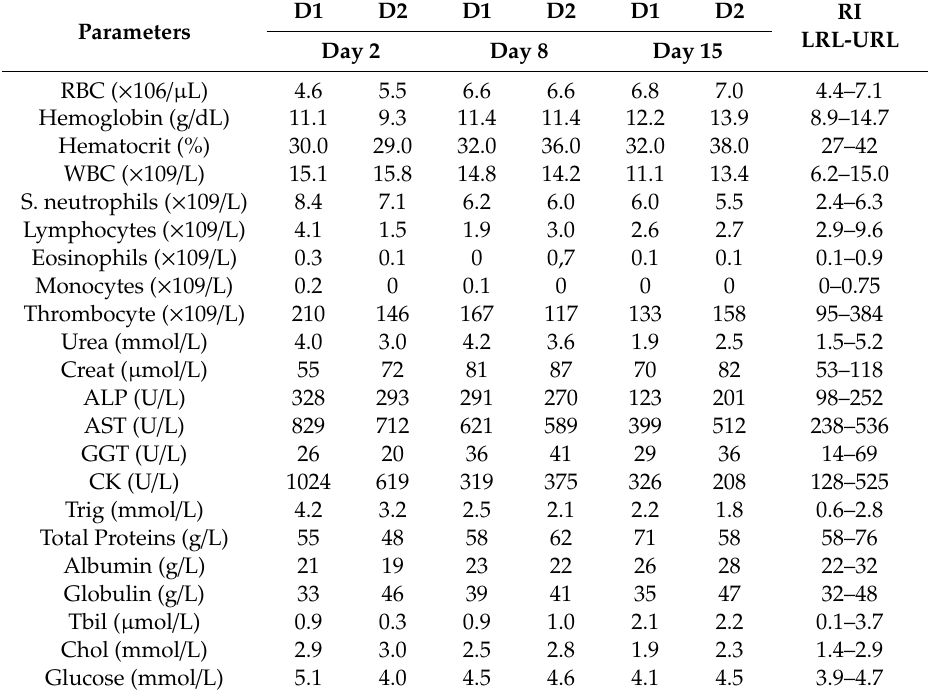
Table 1. Serial complete blood count and serum biochemistry profile of two burned donkeys